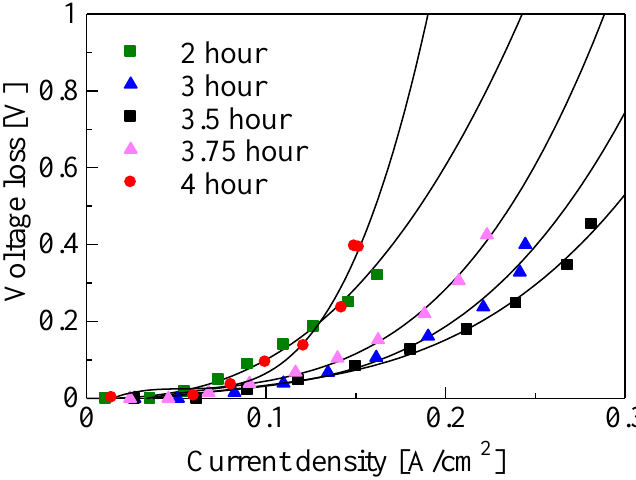
Figure 8. Diffusion polarization for various growth times.